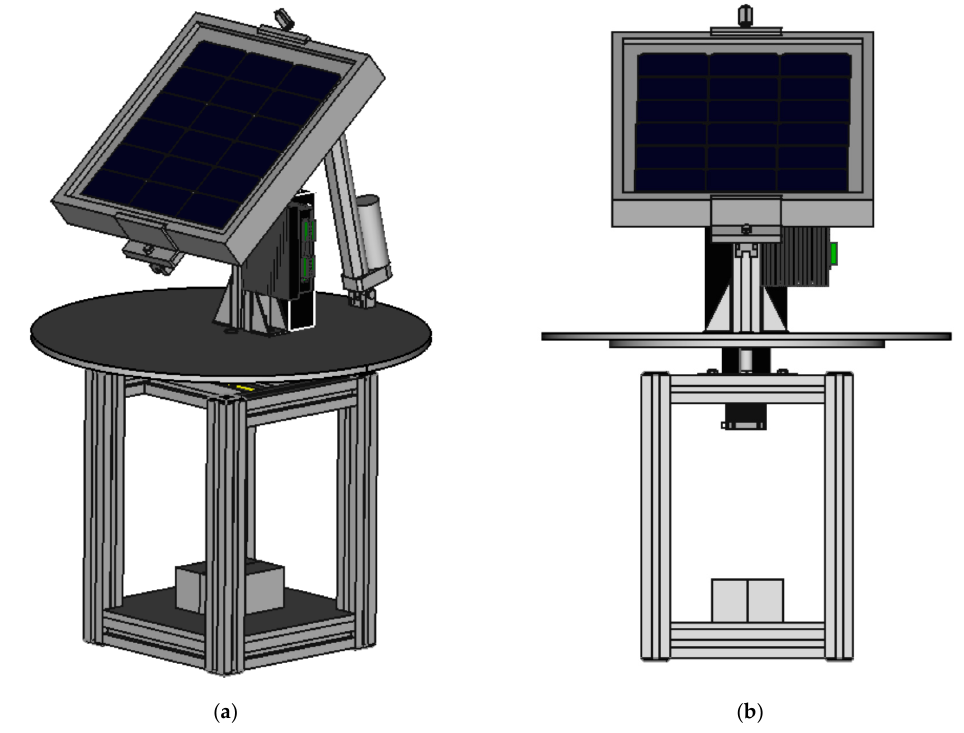
Figure 1. 3D design of photovoltaic solar tracker: ( a ) Perspective of the prototype; and ( b ) front view.